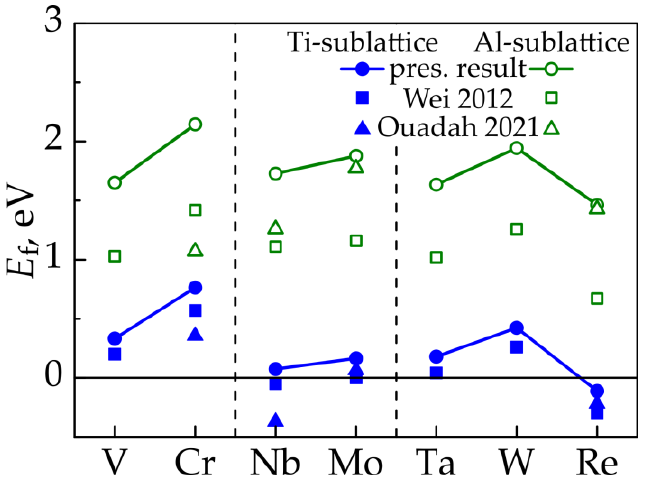
Figure 2. Formation energy ( E f ) of the substitutional defect for both Ti and Al sublattice in comparison with results of Wei 2012 [33] and Ouadah 2021 [35].